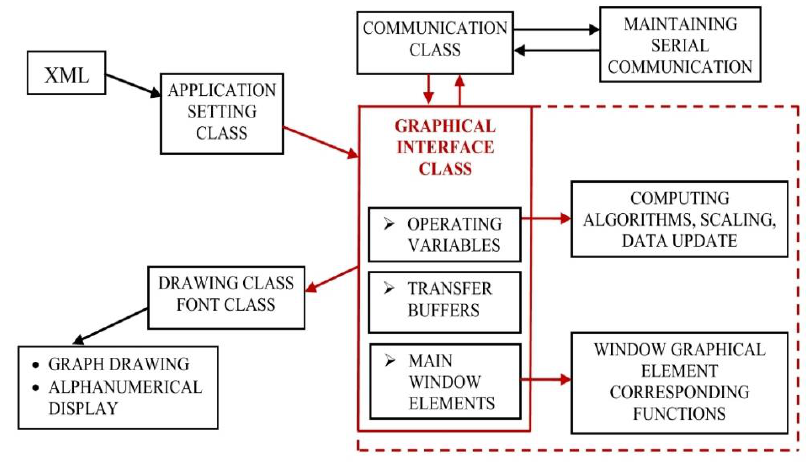
Figure 9. High-level graphical interface components and